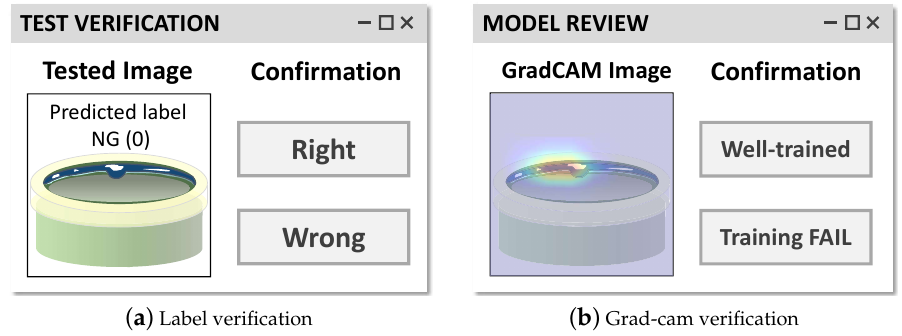
Figure 8. User interface program for verifying unreliable test